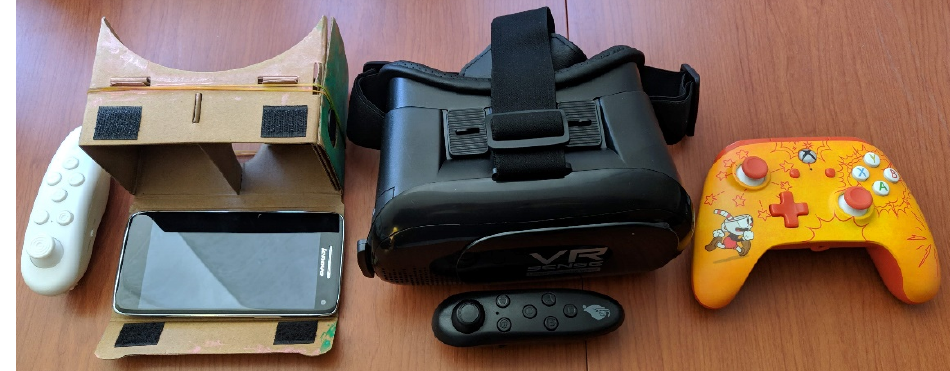
Figure A1. Evaluations for identification and follow-up in children with ADHD. ( a ) Digital electro-encephalogram with brain mapping. ( b ) Frostig test. ( c ) SisAt test. ( d ) and ( e ) Evaluation in children with intellectual disabilities and exercises taken from remote inclusion work booklet, by Unit for Regular Education, Mexico.